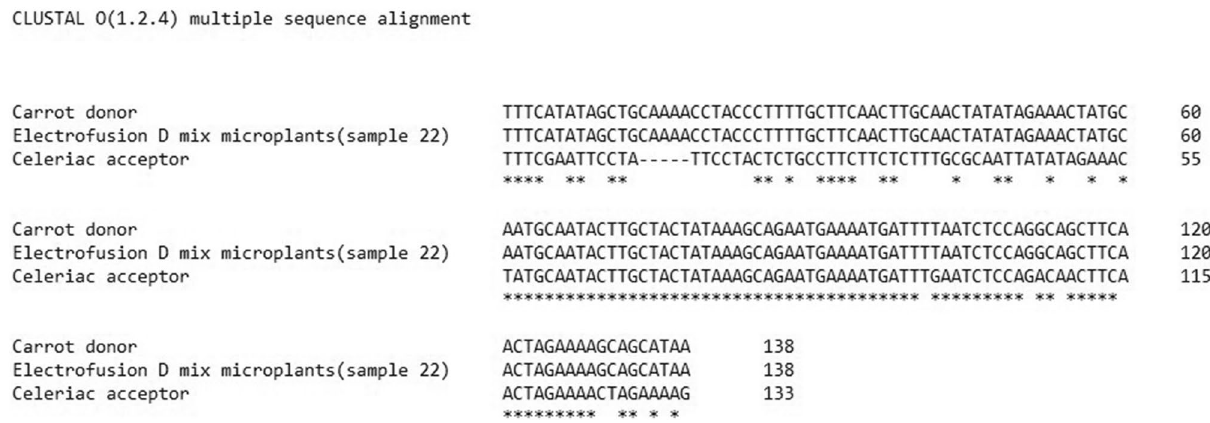
Figure 4. Alignment of the amplicon Atp1 from the electrofusion D microplant sample to the ‘Diamant’ celeriac acceptor and ‘Dolanka’ carrot donor amplicons. The fusion derived samples is identical to the